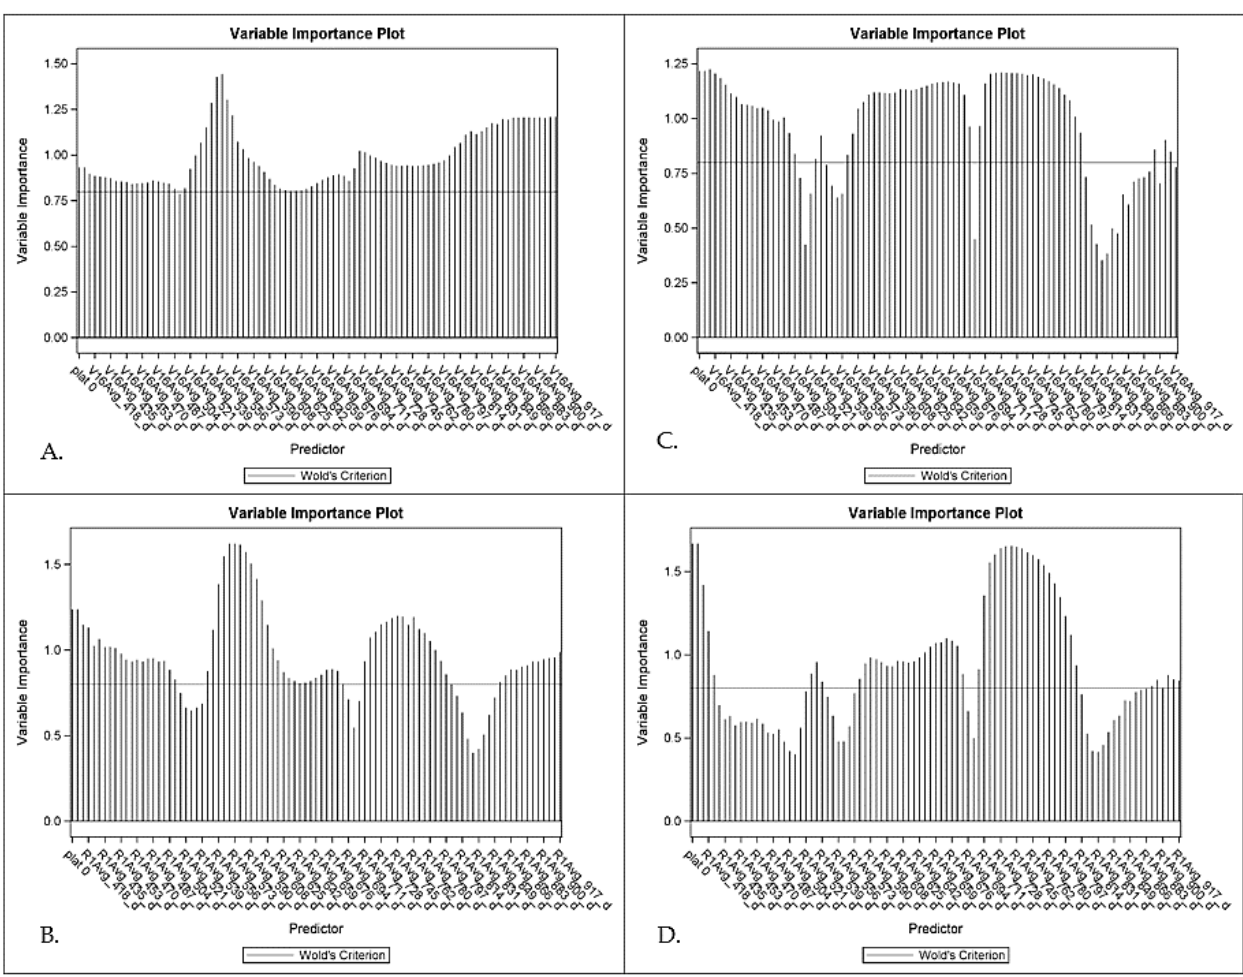
Figure 5. Plots of Variable Importance for Projection (VIP) values for NCE at V16 ( A ), NCE at R1 ( B ), NIE at V16 ( C ) and NIE at R1 ( D ). Predictors for each model are shown on the x axis. Line is at reference value of 0.8; values less than 0.8 are deemed not important as per [44].